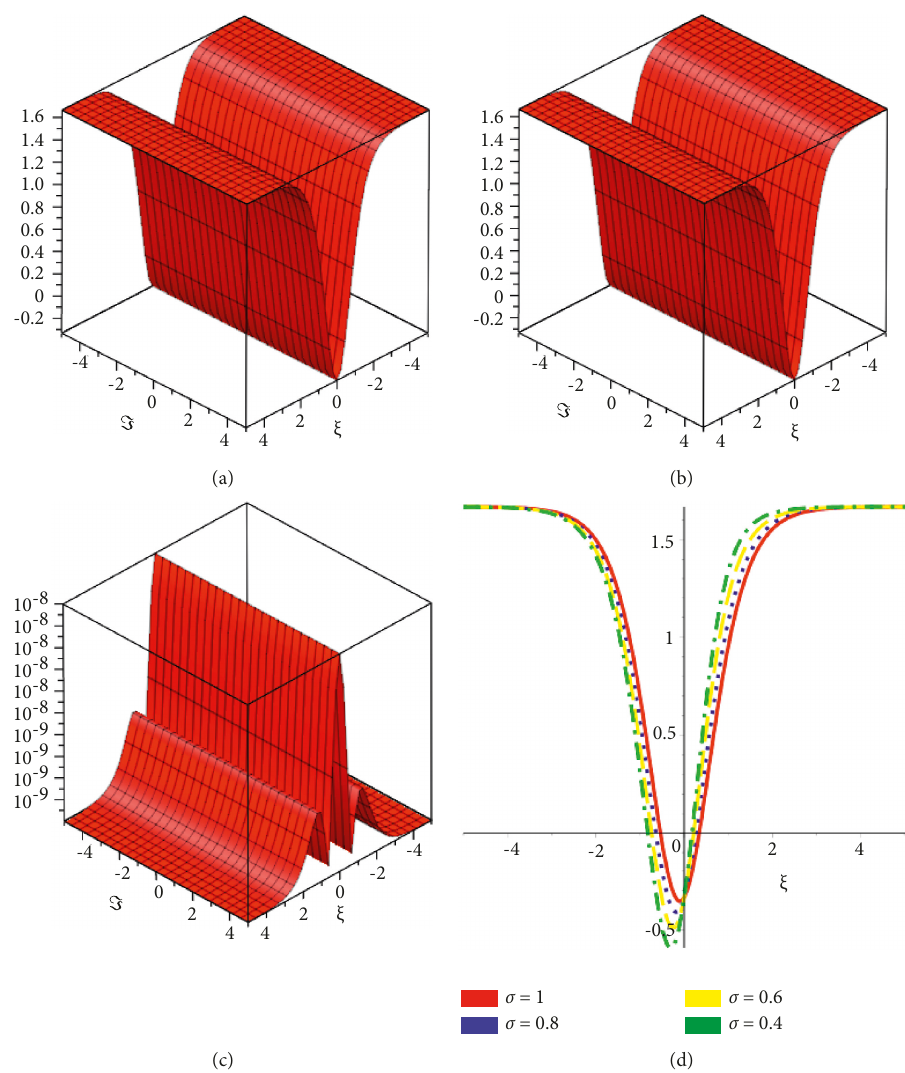
Figure 3: Exact solution, analytical solution, absolute error, and various fractional order solutions for φ ( ξ , I ) of problem